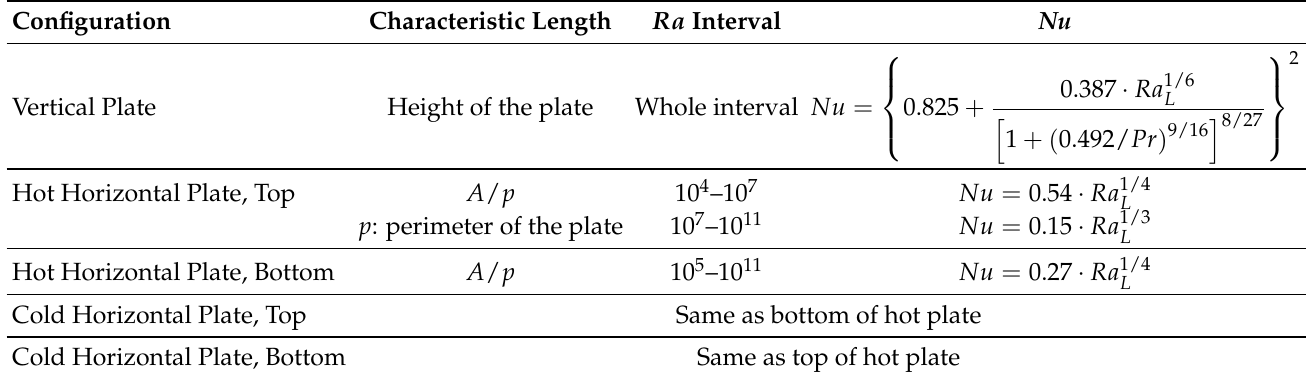
Table 2. Correlations for horizontal and vertical plates.